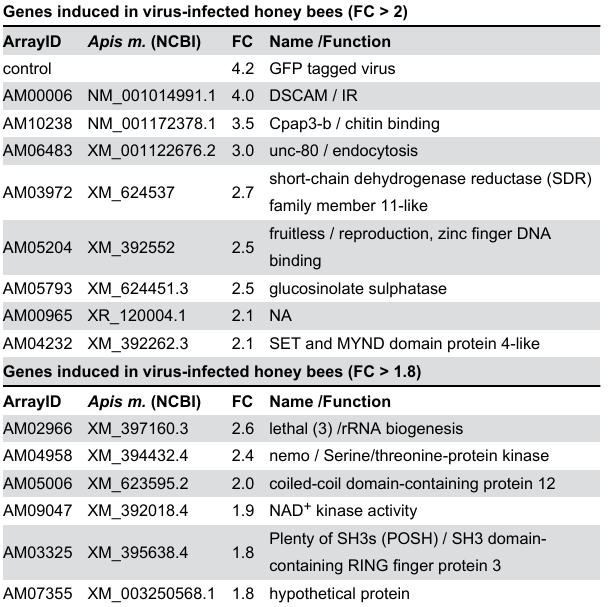
Table abbreviations are as follows: microarray feature identification number = Array ID; honey bee NCBI reference number = Apis m. (NCBI); fold-change = FC; and